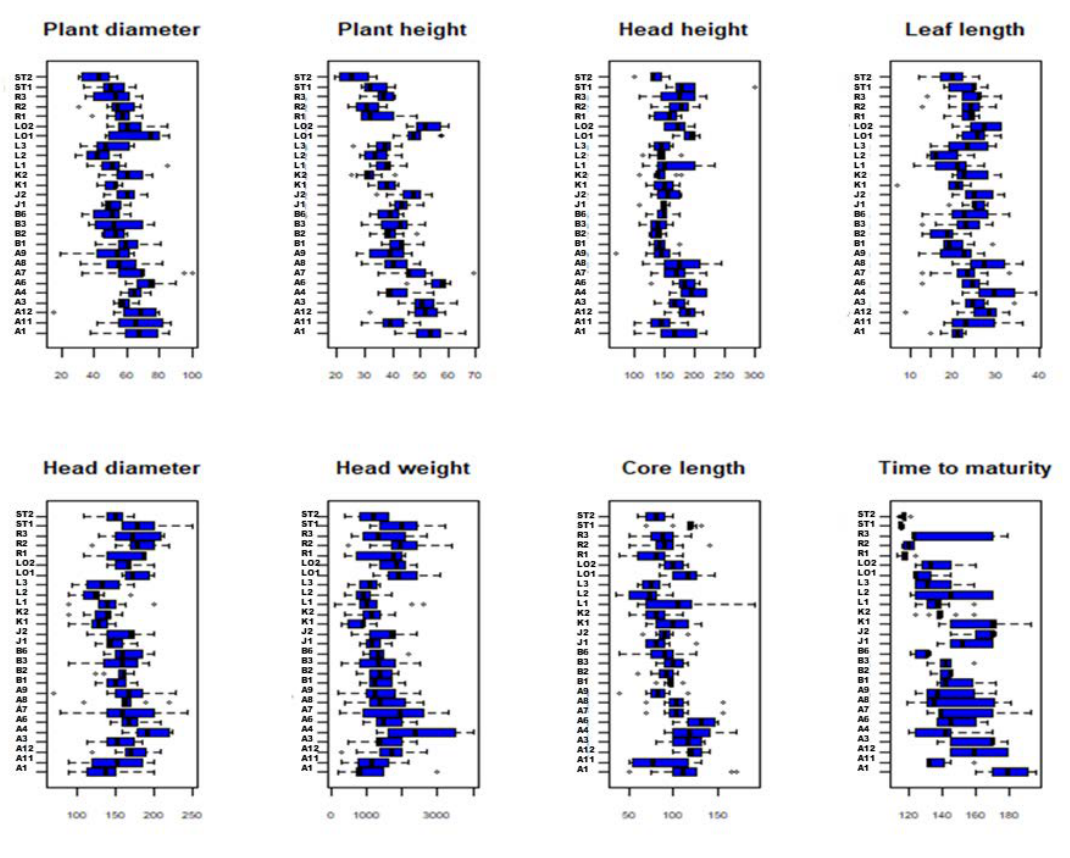
Figure 2. Boxplots describing the variation in the continuous morphological descriptors. Accession names are abbreviated as codes; see Table